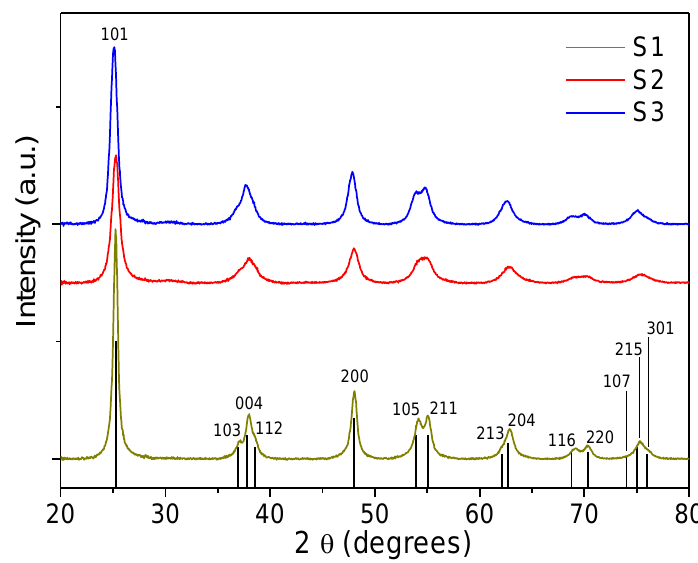
Figure 3. XRD patterns of samples S1, S2, and S3. All samples could be indexed with the JCPDS file No. 21-1272 for anatase TiO 2 structure, which is presented as black vertical bars at the bottom of the figure.